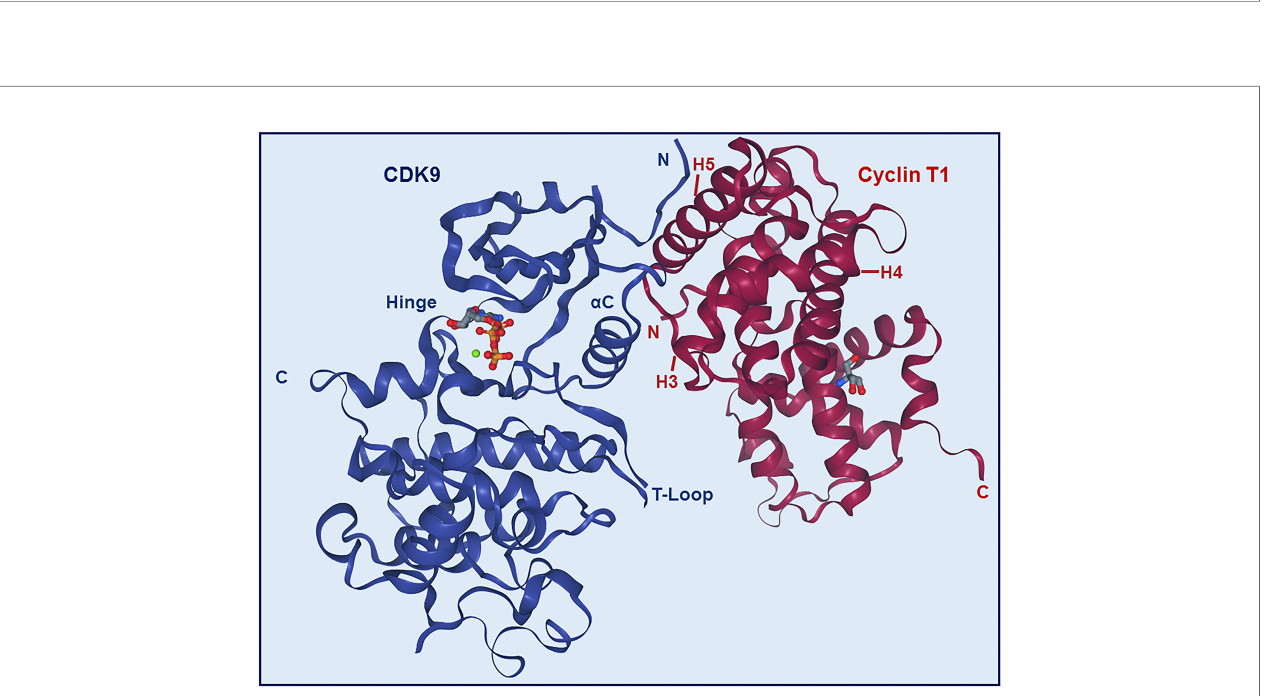
FIGURE 4 | Structure of CDK9-Cyclin T1 complex. Stereo ribbon plot of the 3D structure of CDK9-cyclin T1 in complex with ATP (Protein data bank: 3BLQ). CDK9 (blue) and cyclin T1 (dark red) make contact through the a C helix and b 4 strand of CDK9 and H3, H4, and H5 helices of cyclin T1. The CDK9 T-loop and hinge regions are